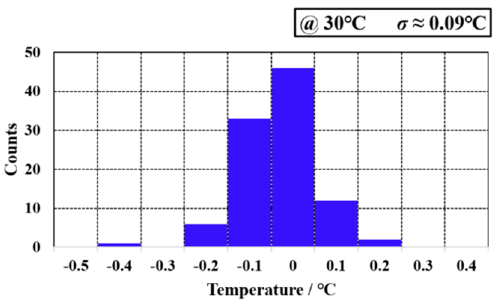
Figure 19. Measured histogram of 100 sensors readings at 30 °C .